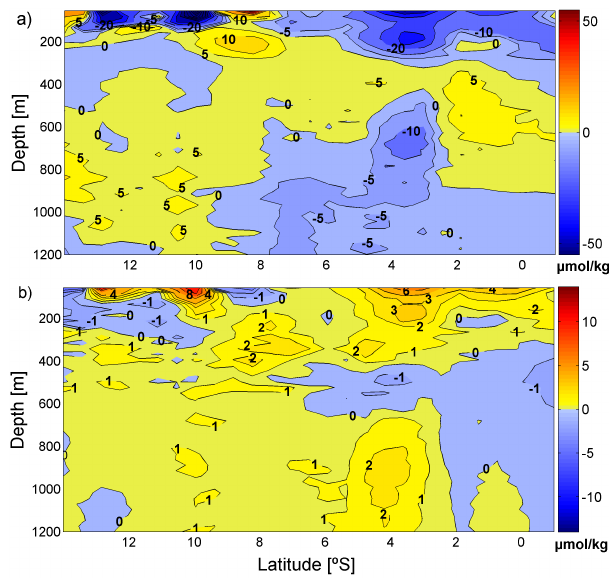
Fig. 8. Measured (a) oxygen (µmolkg − 1 ) and (b) nitrate (µmolkg − 1 ) changes between March 1993 and February 2009